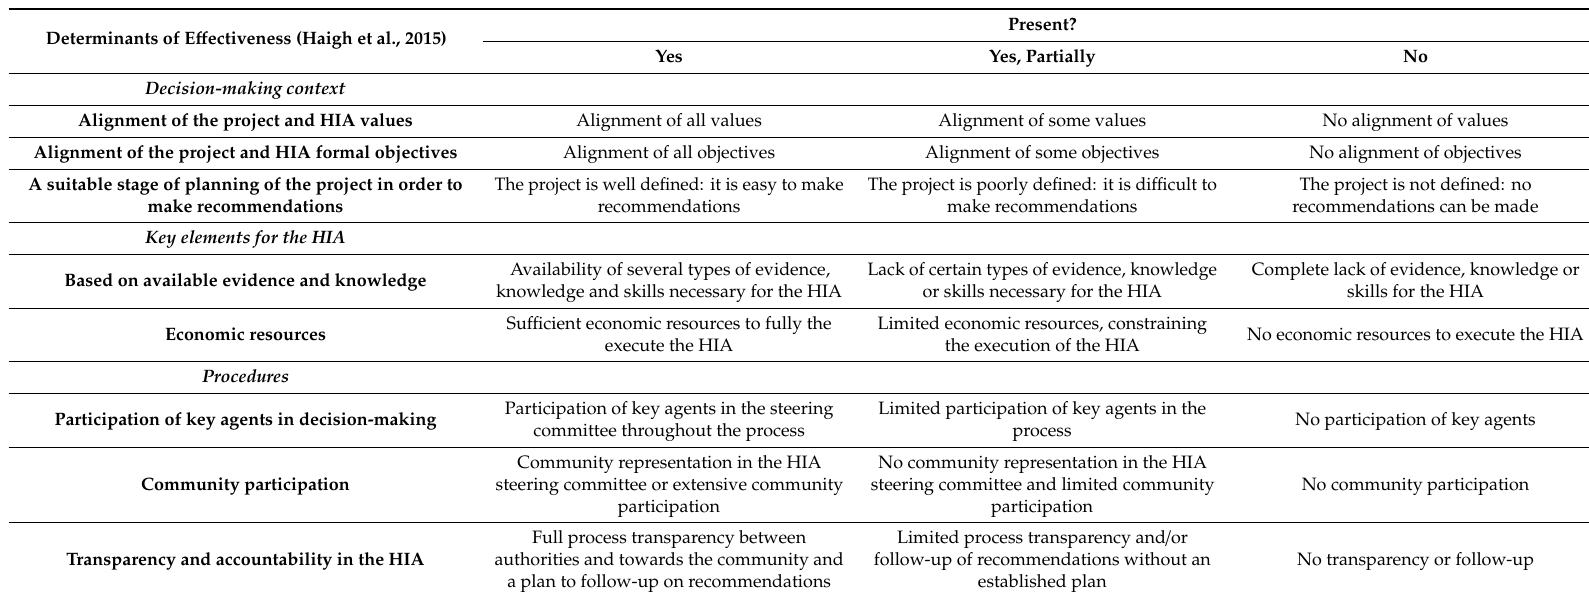
Table 2. Criteria for evaluating the presence of determinants of e ff ectiveness of each